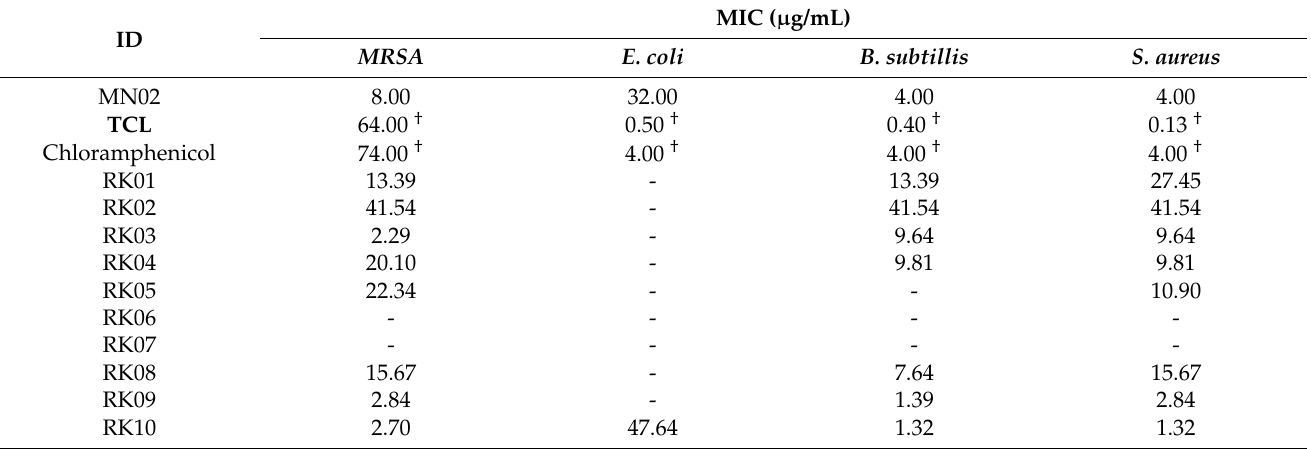
Table 2. The MIC values ( µ g/mL) of our best hits along with the positive standard tested against different bacterial